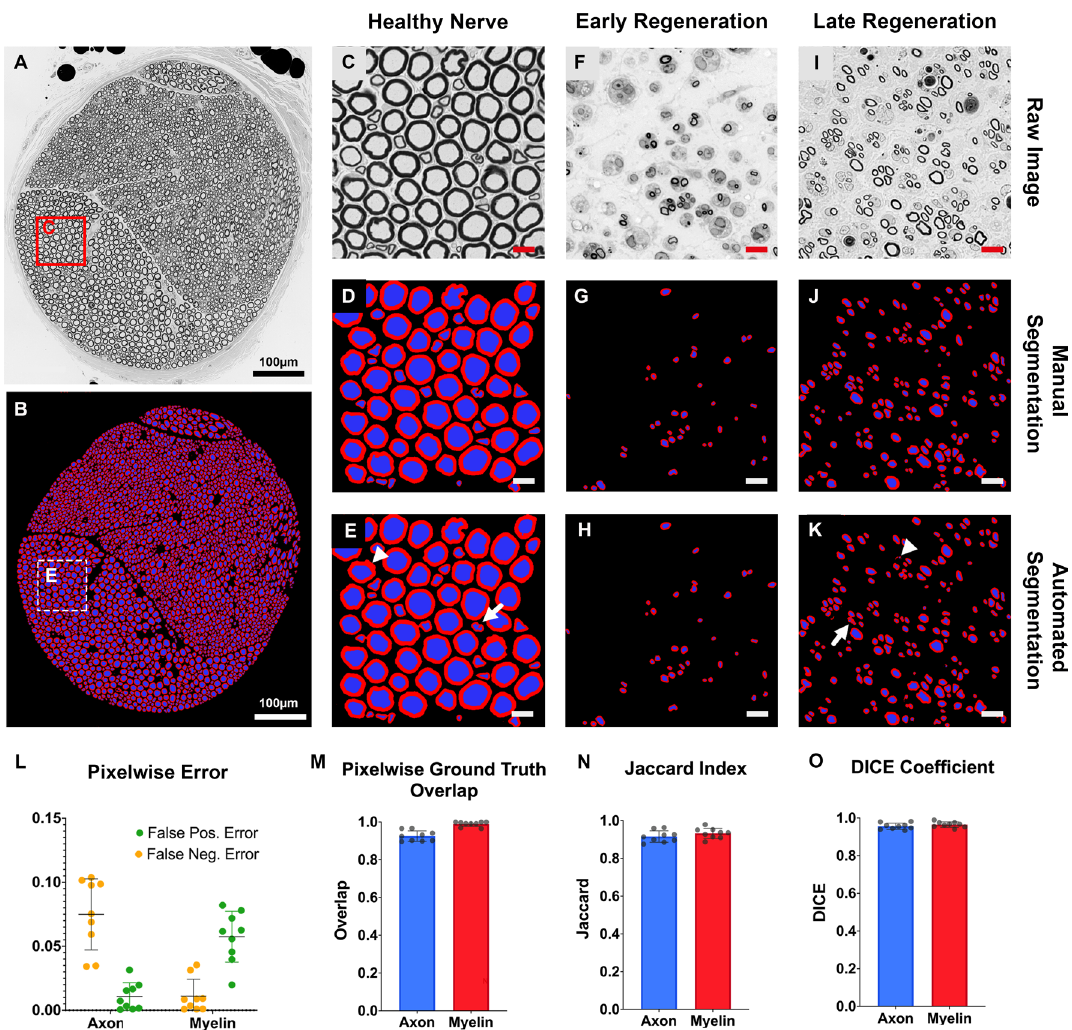
Figure 1. Pixelwise accuracy of automated axon/myelin segmentation. ( A ) Cross-section of a normal rat median nerve from the evaluation dataset. Myelinated axons are shown as black circles. Osmium tetroxide postfixed, epoxy embedded, 1 µm thickness. ( B ) Automated axon/myelin segmentation of the cross-section shown in A. ( C ) Magnified region of interest (ROI) from A. ( D ) Manual segmentation of myelin sheaths and axons of the ROI shown in C. ( E ) Automated segmentation of the ROI shown in C. Myelin sheaths are shown in red and axons are shown in blue in D and E. White arrows indicate segmentation inaccuracies due to processing artifacts of the myelin sheath (arrowhead) and irregularly shaped nerve fibers (white arrow). Scale bar represents 10 µm. ( F ) ROI from a rat common peroneal nerve in an early regeneration state, 3 weeks following nerve transection and epineural repair, 10 mm distal to the nerve repair site. ( G ) Manual and ( H ) automated segmentation of myelin sheaths and axons of the ROI shown in F. ( I ) ROI from a rat median nerve in a later regeneration state, 7 weeks following nerve transection and epineural repair, 10 mm distal to the nerve repair site. ( J ) Manual and ( K ) automated segmentation of myelin sheaths and axons of the ROI shown in I. White arrows indicate areas of over segmentation (arrowhead) and segmentation inaccuracies of singular nerve fibers with a complex shape (white arrow). ( L ) Pixelwise false positive and negative error for the automated axon and myelin segmentation compared to the ground truth. ( M ) Pixelwise overlap of the automated axon/ myelin segmentations with the ground truth. ( N ) The Jaccard similarity index and ( O ) DICE coefficient indicate excellent similarity of the automated and manual axon and myelin segmentations. (own illustration created with Axon diameter, myelin sheath thickness and g-ratio are key metrics for clinicians and researchers alike. They are frequently used for diagnosis and staging of neuropathic diseases 1–3 and are commonly accepted outcome measures in nerve regeneration studies 4–6 . However, extremity nerves in common experimental rodent models include thousands of nerve fibers. Therefore, time consuming manual morphometry, although still frequently applied to this day, is usually limited to selected regions of interest (ROIs) and requires subsequent extrapola- tion. Due to the heterogenous distribution of morphologically and functionally distinct nerve fiber populations within peripheral nerves 7 (Fig. 1A), the number of analyzed fibers and the size, number and location of selected